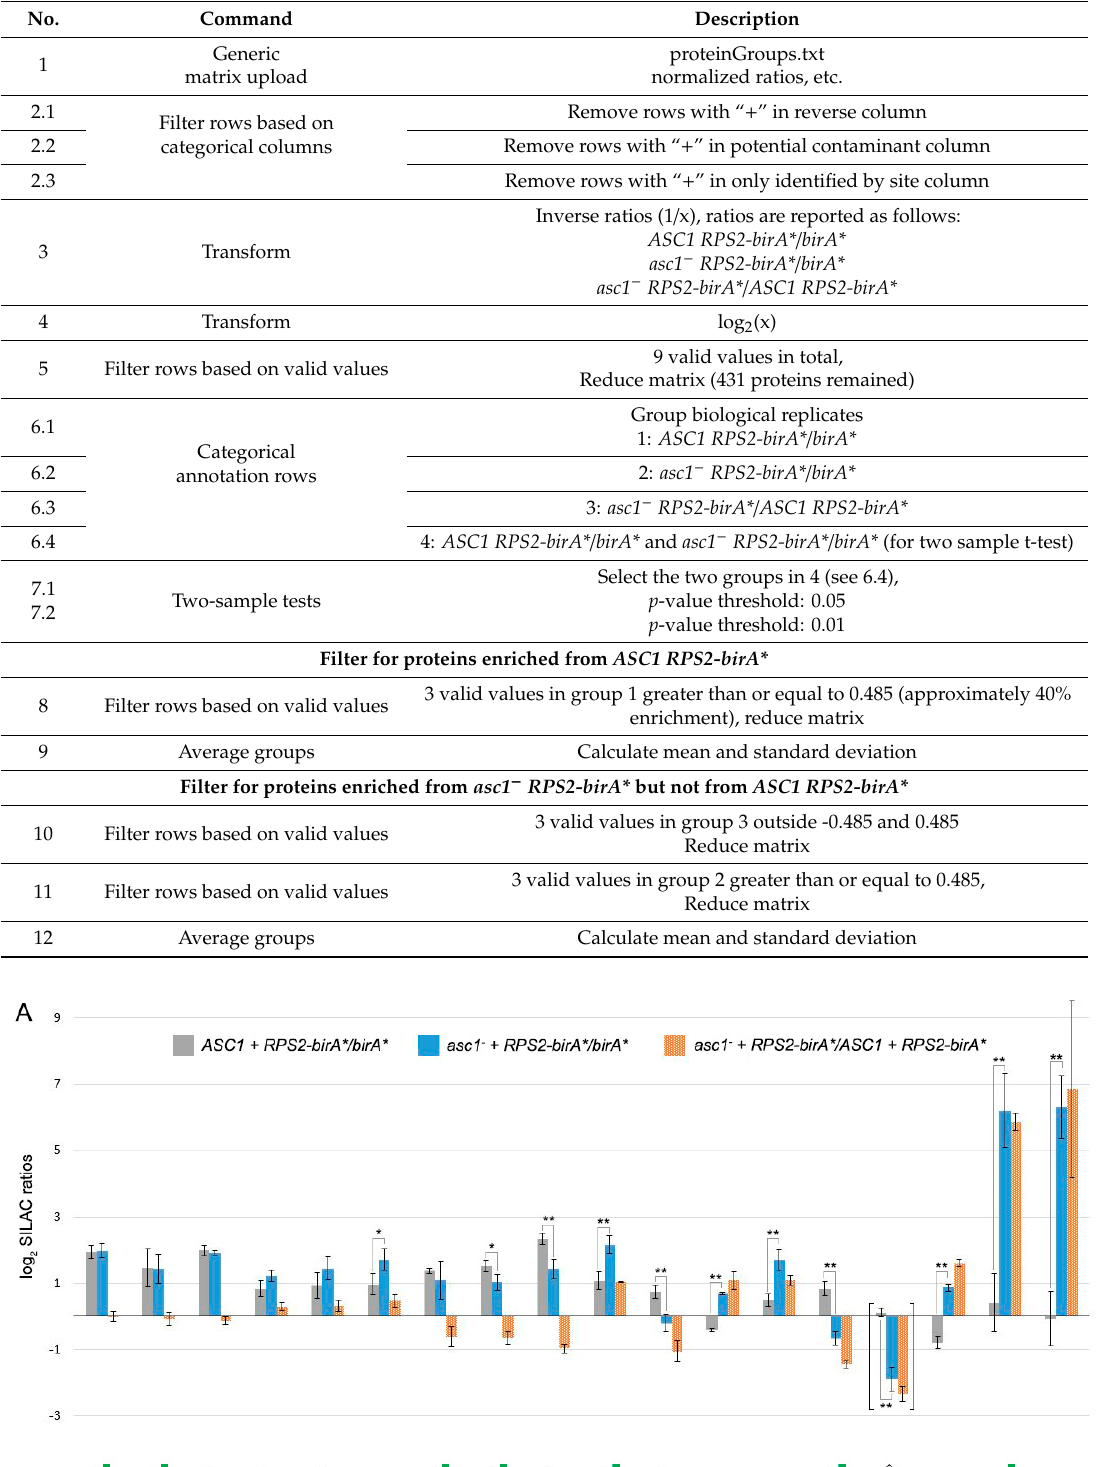
Table 3. Overview of MaxQuant output data evaluation with Perseus. The table lists the main steps of the Perseus analysis.